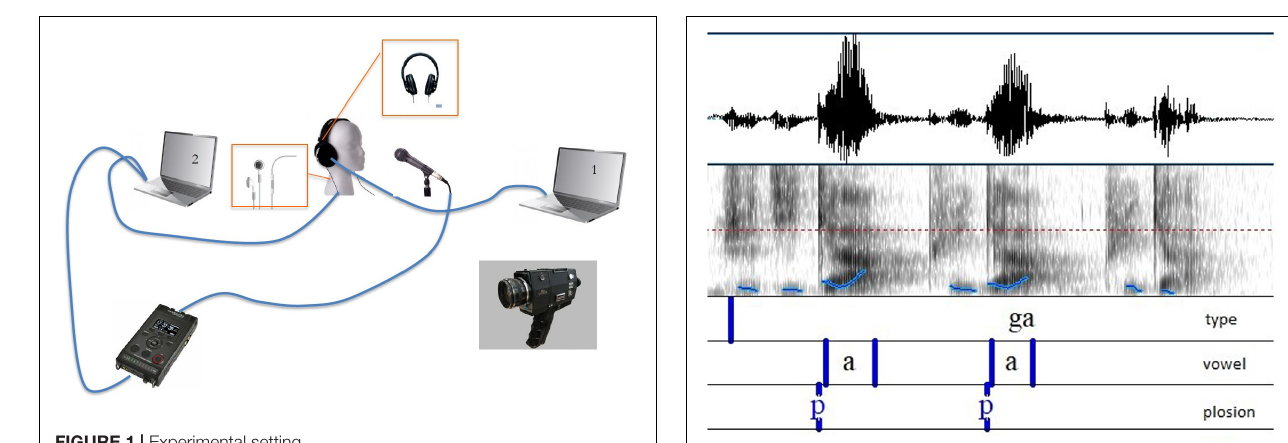
FIGURE 1 | Experimental setting.